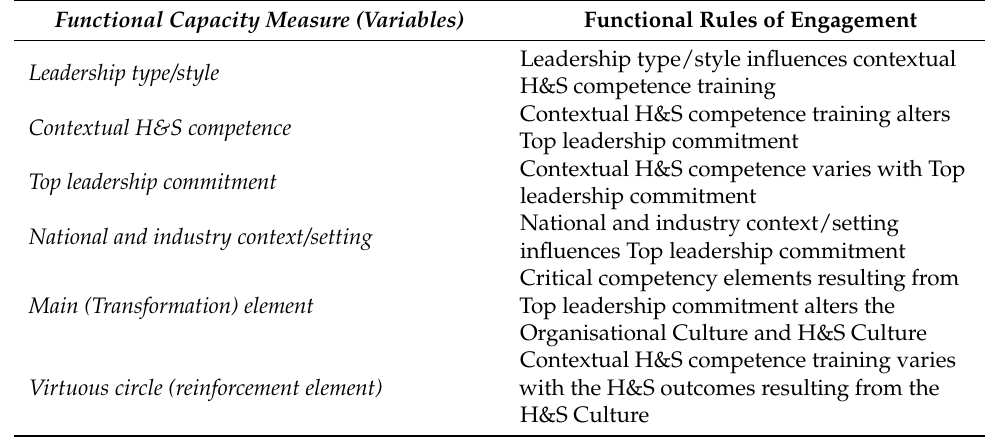
Table 1. Functional content measures for the